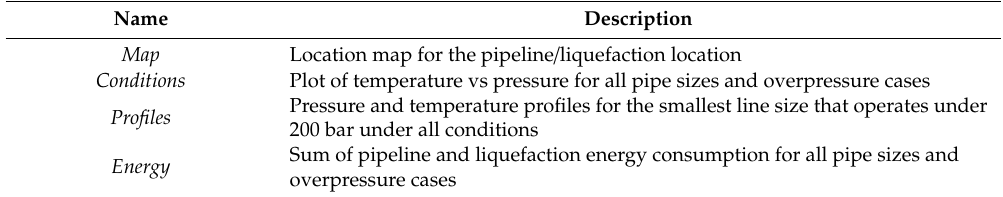
Table 5. Summary Plots Generated by the